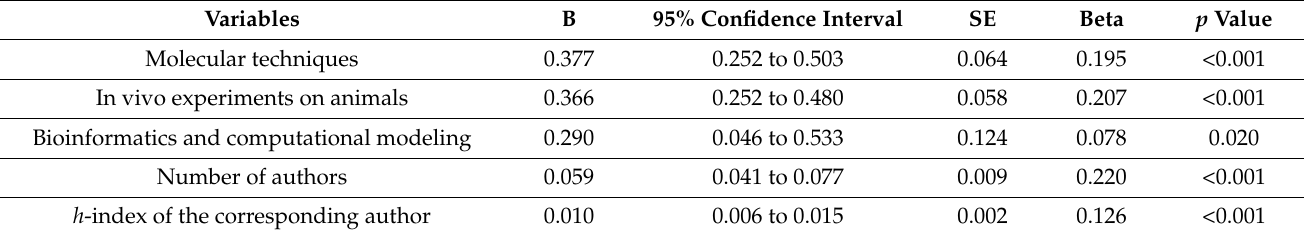
Table 3. Associations between study characteristics/research techniques and journal impact